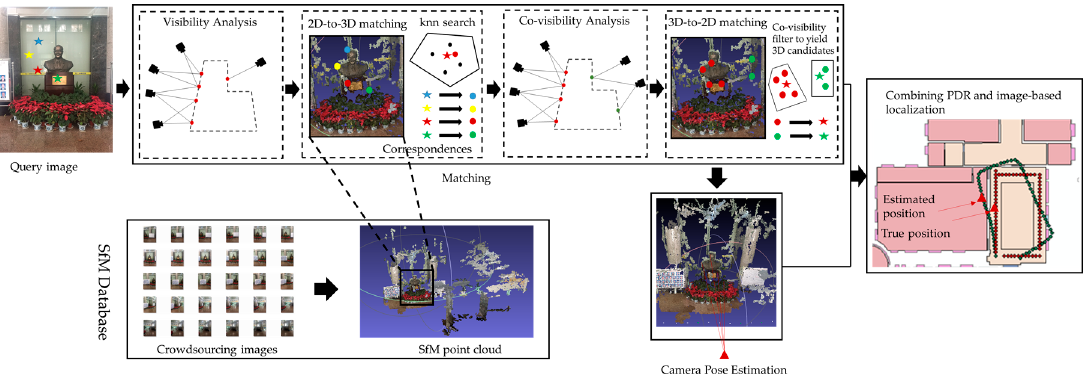
Figure 1. The workflow of the image localization based pedestrian trajectory estimation algorithm.